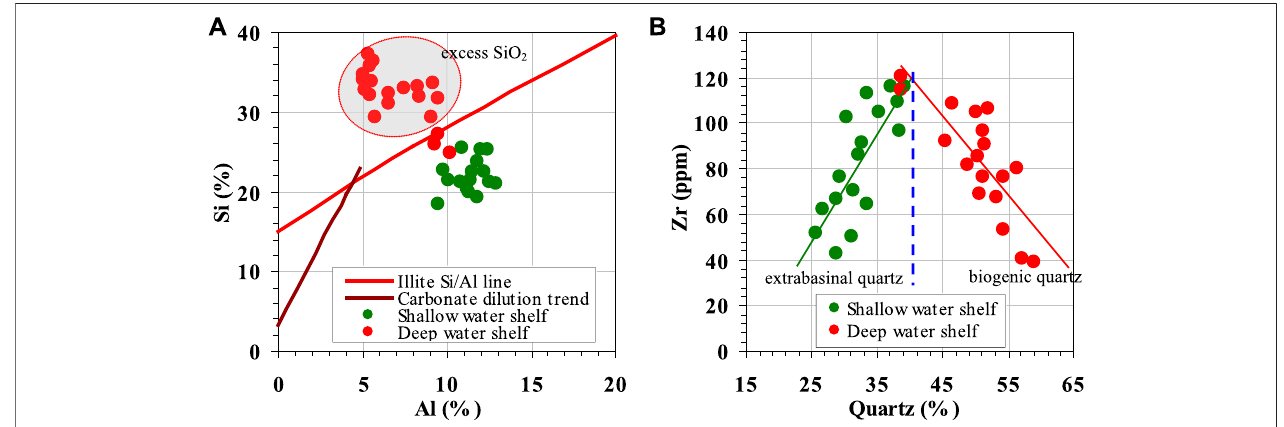
FIGURE 13 | (A) Crossplot of Si and Al of Wufeng-Longmaxi Formation shale on the background of illite Si/Al line and carbonate dilution line (Rowe et al., 2008). Excess SiO 2 indicates the biogenic quartz. (B) Crossplot of SiO 2 versus Zr. Bioenic quartz is distinguished from extrabasinal quartz by the slope. Data points are sorted by sedimentary